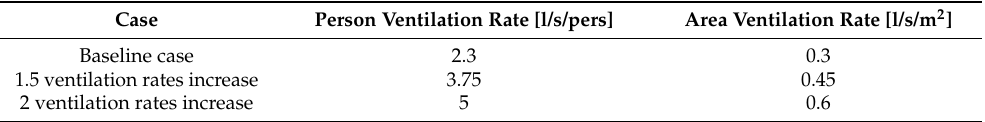
Table 6. Increase in ventilation